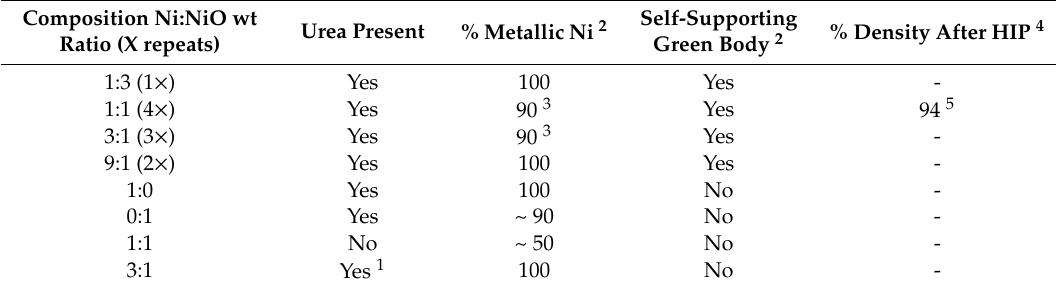
Table 1. The samples created using the standard